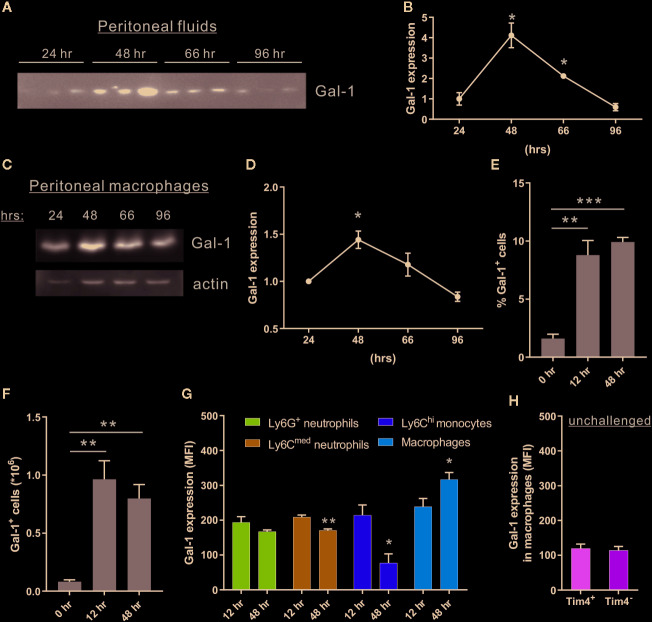
Peritoneal macrophages increase the expression of Gal-1 in response to acute inflammation. WT mice were injected intraperitoneally with zymosan A (1 mg/mouse in 1 ml of PBS) to initiate peritonitis. Peritoneal exudates were collected at 0, 24, 48, 66, and 96 h post peritonitis initiation (PPI). Cell-free fluids were separated, peritoneal cells were examined by flow cytometry (see
Figure S1C
 for gating strategy), and macrophages were isolated from the cellular fraction using magnetic beads. (A–D) Peritoneal fluids (A, B) and lysates from macrophages (C, D) were run by SDS-PAGE, followed by immunoblotting for Gal-1 and actin as a loading control. (A, C) Representative blot images. (B, D) Gal-1 protein expression was quantified by densitometry, and expression relative to 24 h was calculated. Original blot images are presented in
Figure S7
. (E–H) Peritoneal leukocytes were enumerated, immunostained for the surface antigens Ly6G, Ly6C, F4/80, Tim4, and intracellular Gal-1, and analyzed by flow cytometry. (E, F) Gal-1+ leukocytes are presented in percentage or in total numbers/ml in peritoneal fluids, n = 4. (G, H) Intracellular Gal-1 expression (MFI) in the following leukocyte populations: Ly6G+F4/80- neutrophils, Ly6CmedF4/80- neutrophils, Ly6ChiF4/80lo monocytes, F4/80+Ly6C- macrophages, F4/80+Tim4- monocyte-derived resident macrophages and F4/80+Tim4+ yolk sac-originated resident macrophages, n = 4. Altogether, the data represent at least 2 independent experiments and are presented as mean ± SEM. Statistical analysis by two-tailed Student's t-test; *p < 0.05, **p < 0.01, ***p < 0.001.